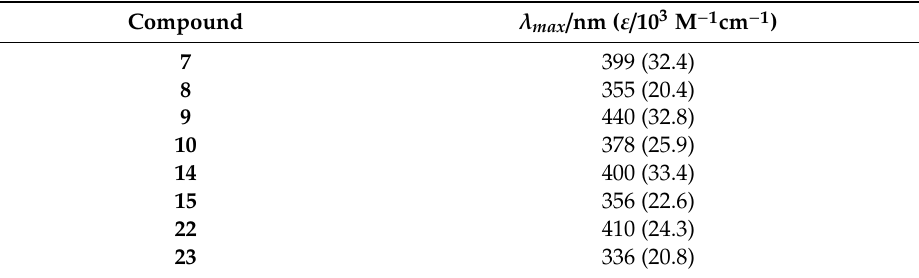
Figure 3. UV-Vis absorption spectra of naphtho- and phenanthro-fused NBDs 14 , 15 , 22 and 23 recorded in toluene. Table 1. Longest-wavelength absorption maxima ( λ max / nm) and molar absorptivities ( ε / 10 3 M − 1 cm − 1 ) in